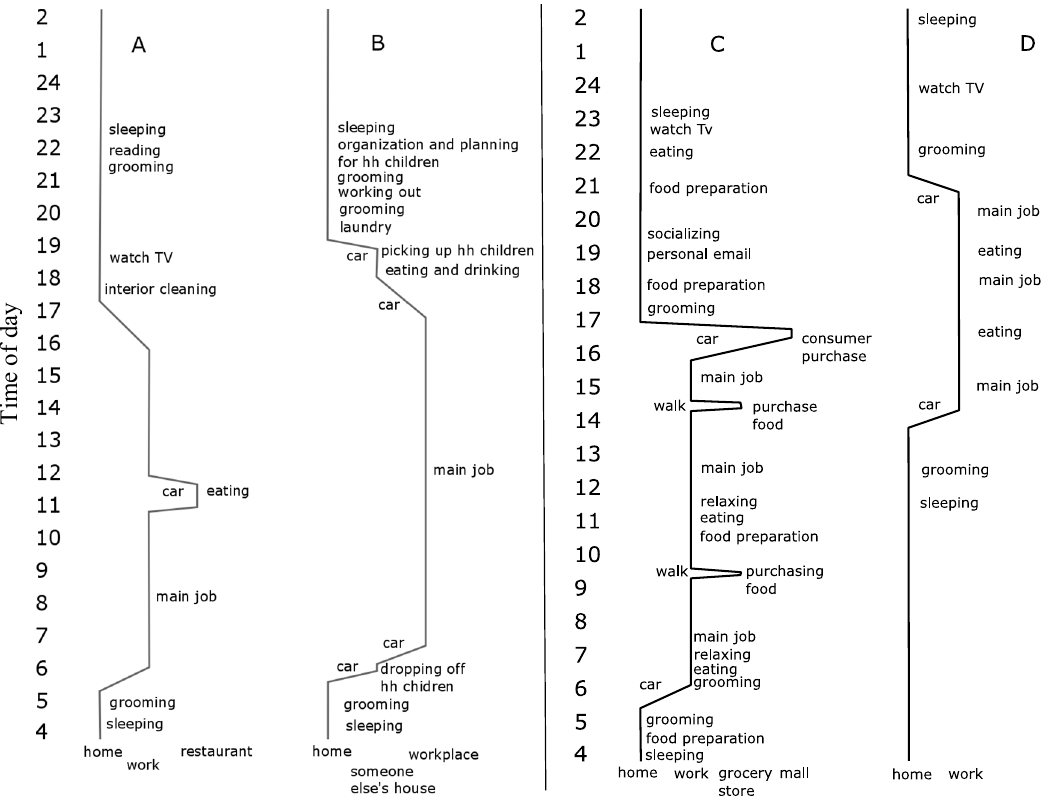
Figure 2. Activity patterns of two sample professional individuals (A&B) with travel time equal to the average of the top 20% and two (C&D) with travel time equal to the average of the bottom 80%. The Y -axis represents time of day, starting from early morning at the bottom and time running upward by hour. The vertical length of a line is the duration of an activity. A discrete X axis represents location of an activity (hh = household), the left-hand vertical line is home, vertical lines to the right of this are workplace, restaurant, or other location. Slanted lines refer to travel between locations.